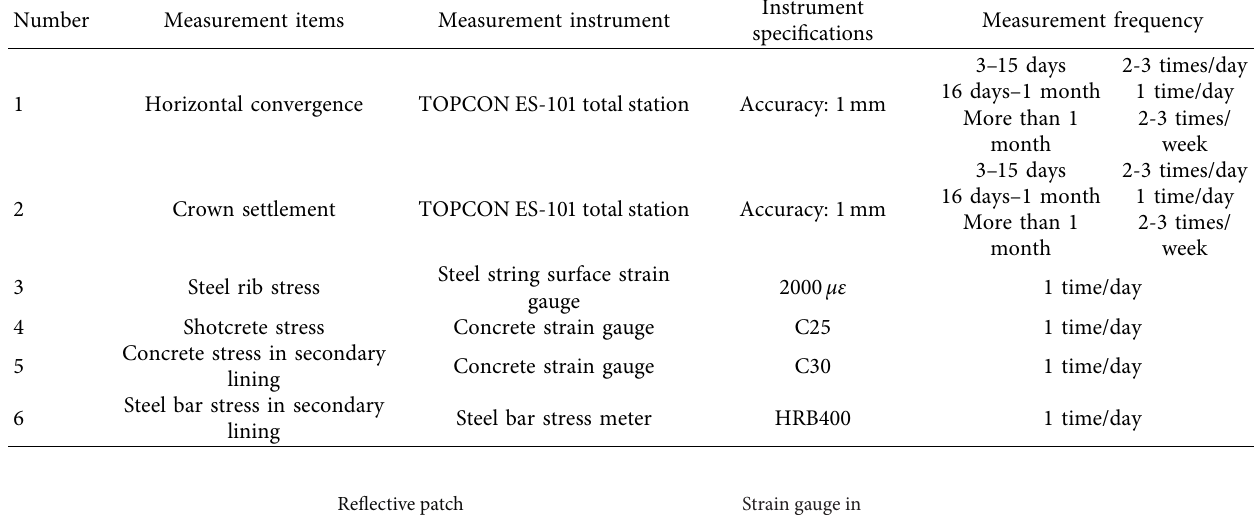
Table 3: Field test items and measurement